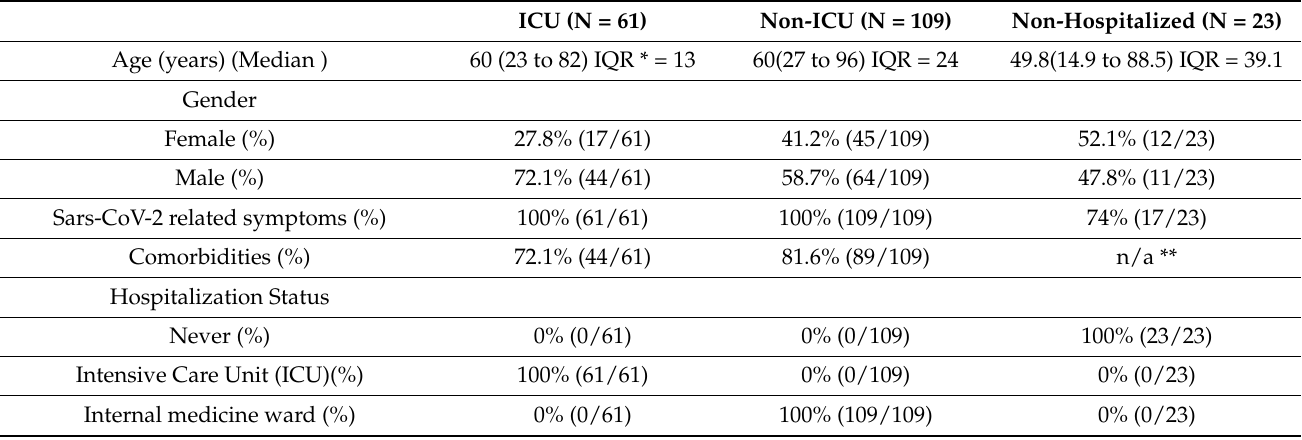
Table 1. Participant